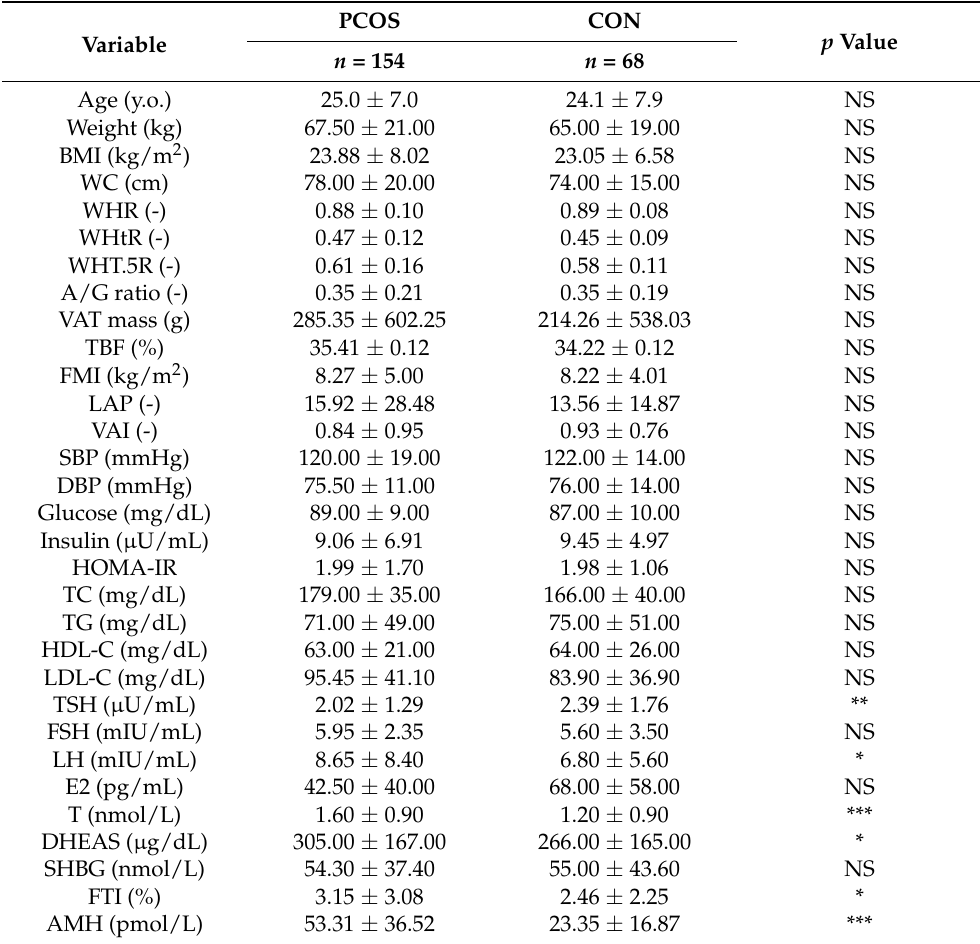
Table 1. General comparison between study (PCOS) and control (CON) samples (median ± in- terquartile range